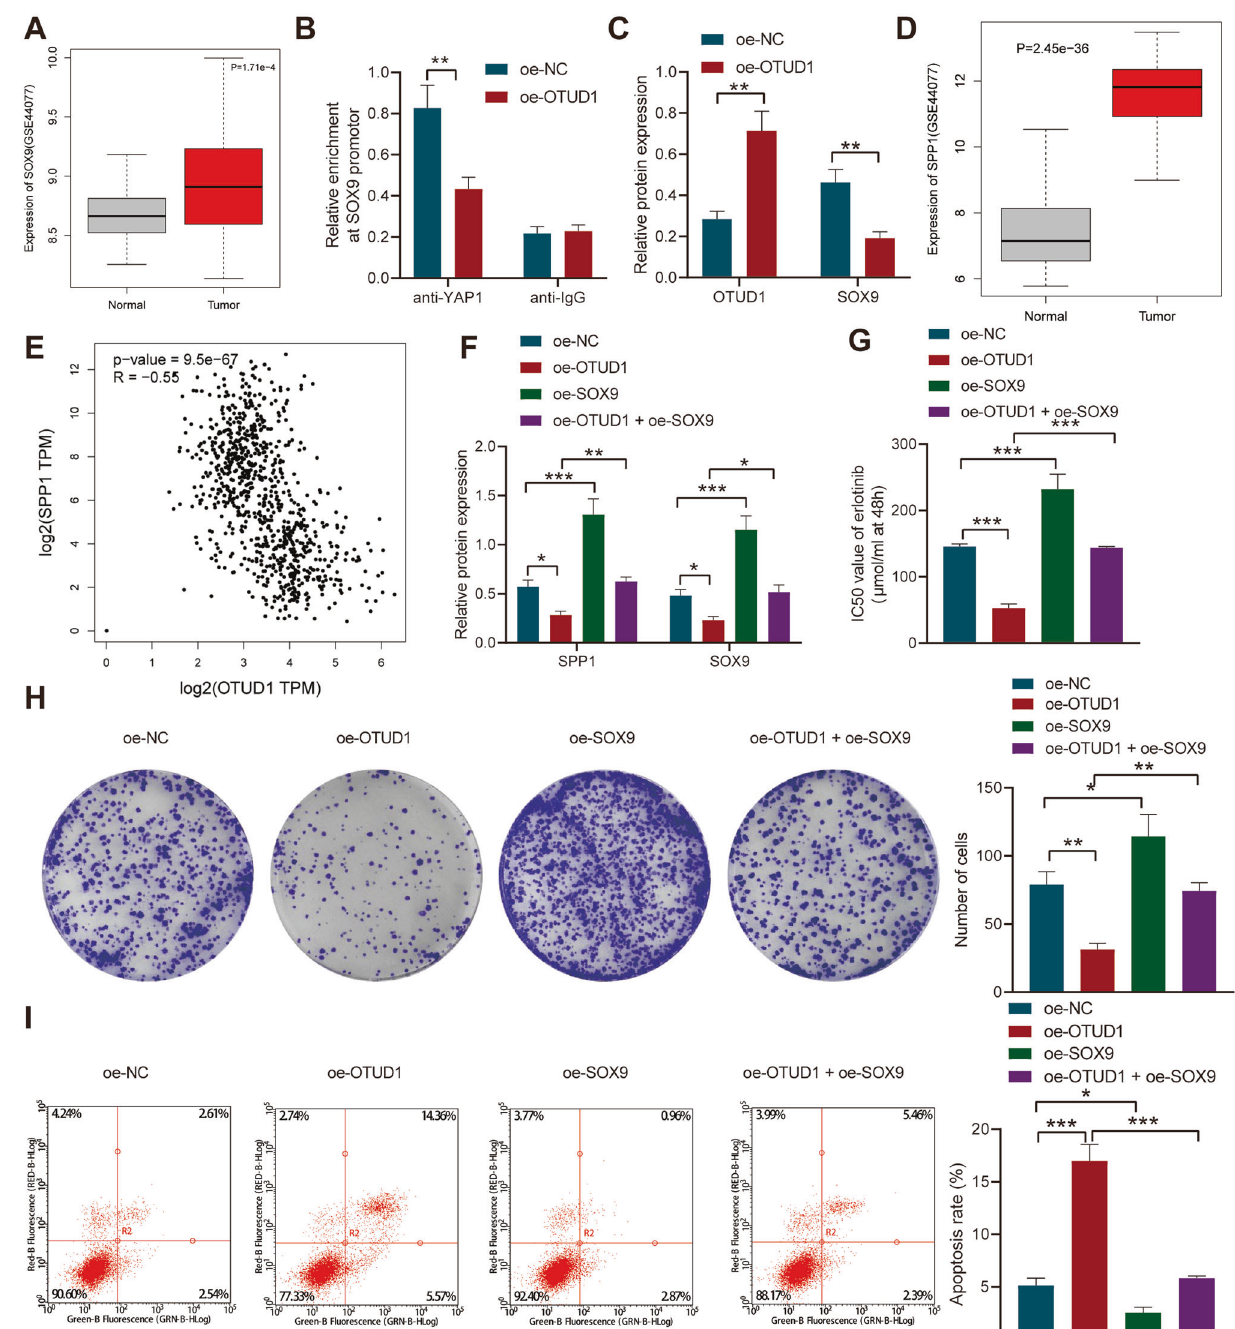
Fig. 5 OTUD1 suppresses resistance of NSCLC cells to erlotinib by inactivating the SOX9/SPP1 axis. A Box plots of SOX9 expression in normal and NSCLC tissue samples in the GSE44077 dataset. B The enrichment of YAP1 in the SOX9 promoter region analyzed by ChIP assay. C Western blot analysis of SOX9 protein in the oe-SOX9-treated PC-9/ER cells. D Box plots of SPP1 expression in normal and NSCLC tissue samples in the GSE44077 dataset. E Correlation analysis of OTUD1 with SPP1 in TCGA database. F Western blot analysis of SPP1 and SOX9 proteins in PC-9/ER cells treated with oe-OTUD1, oe-SOX9 or both. G IC50 value of erlotinib in PC-9/ER cells treated with oe-OTUD1, oe-SOX9 or both determined by CCK-8 assay. H Clonogenic potential of PC-9/ER cells treated with oe-OTUD1, oe-SOX9 or both determined by colony formation assay. I Apoptosis rate of PC-9/ER cells treated with oe-OTUD1, oe-SOX9 or both measured by fl ow cytometry. * p < 0.05, ** p < 0.01, *** p < 0.001. Data are shown as mean ± standard deviation of three technical replicates. Data among multiple groups were compared by one- way ANOVA and Tukey ’ s multiple comparisons